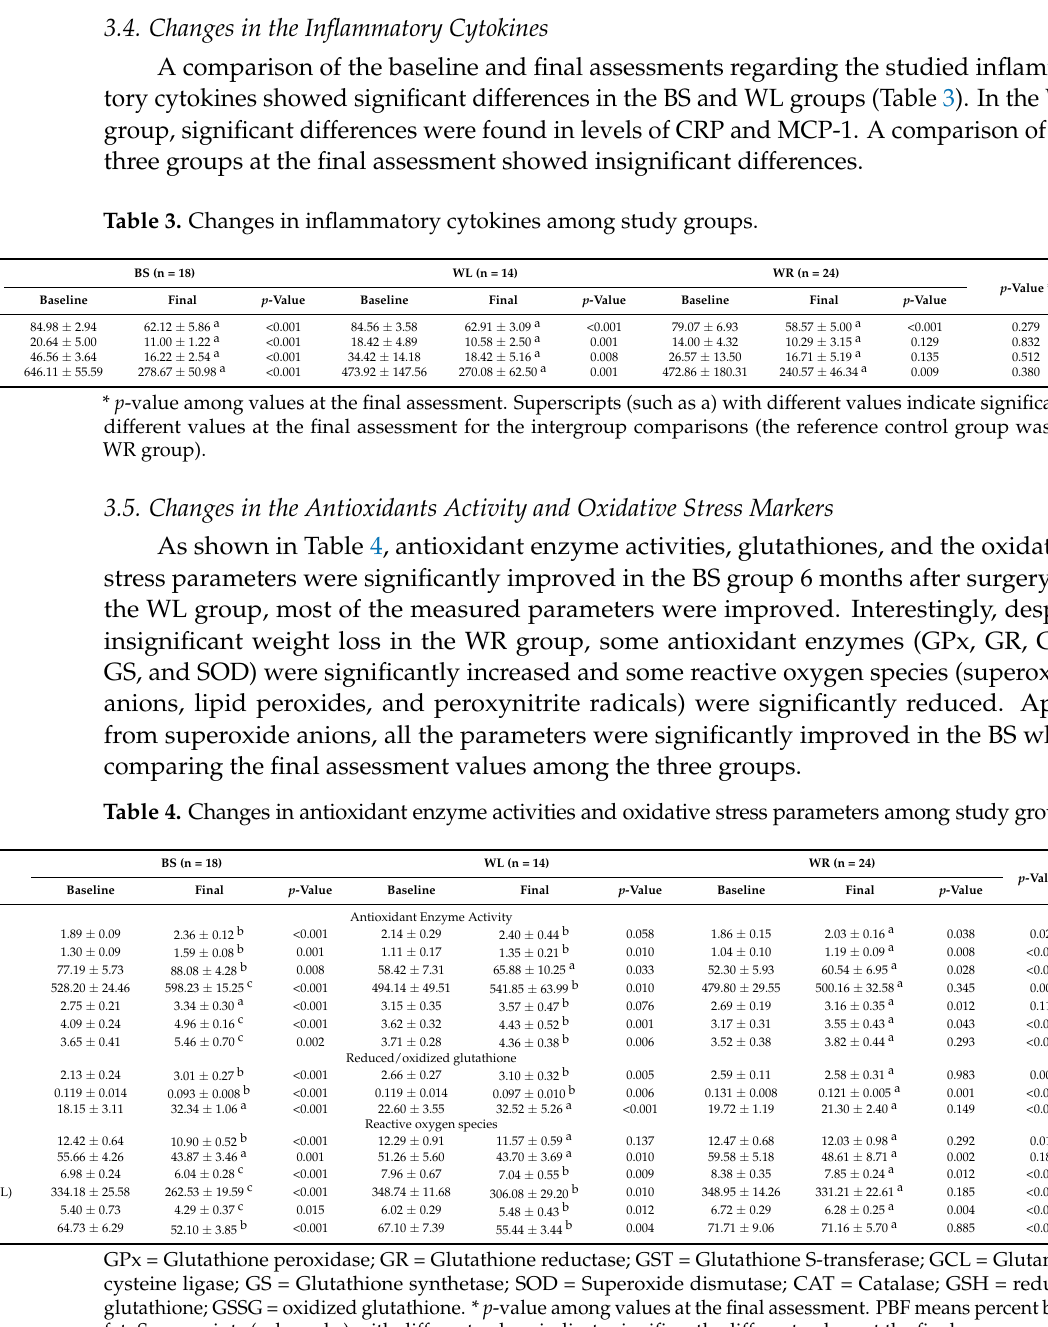
GPx = Glutathione peroxidase; GR = Glutathione reductase; GST = Glutathione S-transferase; GCL = Glutamate cysteine ligase; GS = Glutathione synthetase; SOD = Superoxide dismutase; CAT = Catalase; GSH = reduced glutathione; GSSG = oxidized glutathione. * p -value among values at the final assessment. PBF means percent body fat. Superscripts (a, b, and c) with different values indicate significantly different values at the final assessment for the intergroup comparisons (the reference control group was the WR